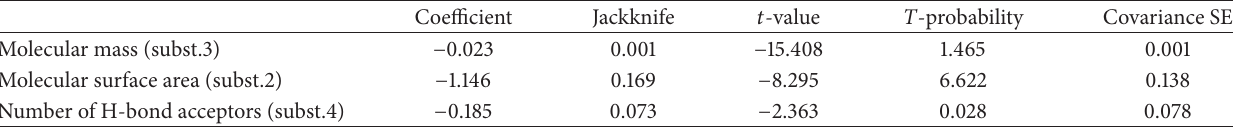
Table 3: Statistical data of the independent variable illustrating the significance in terms of statistical parameters.